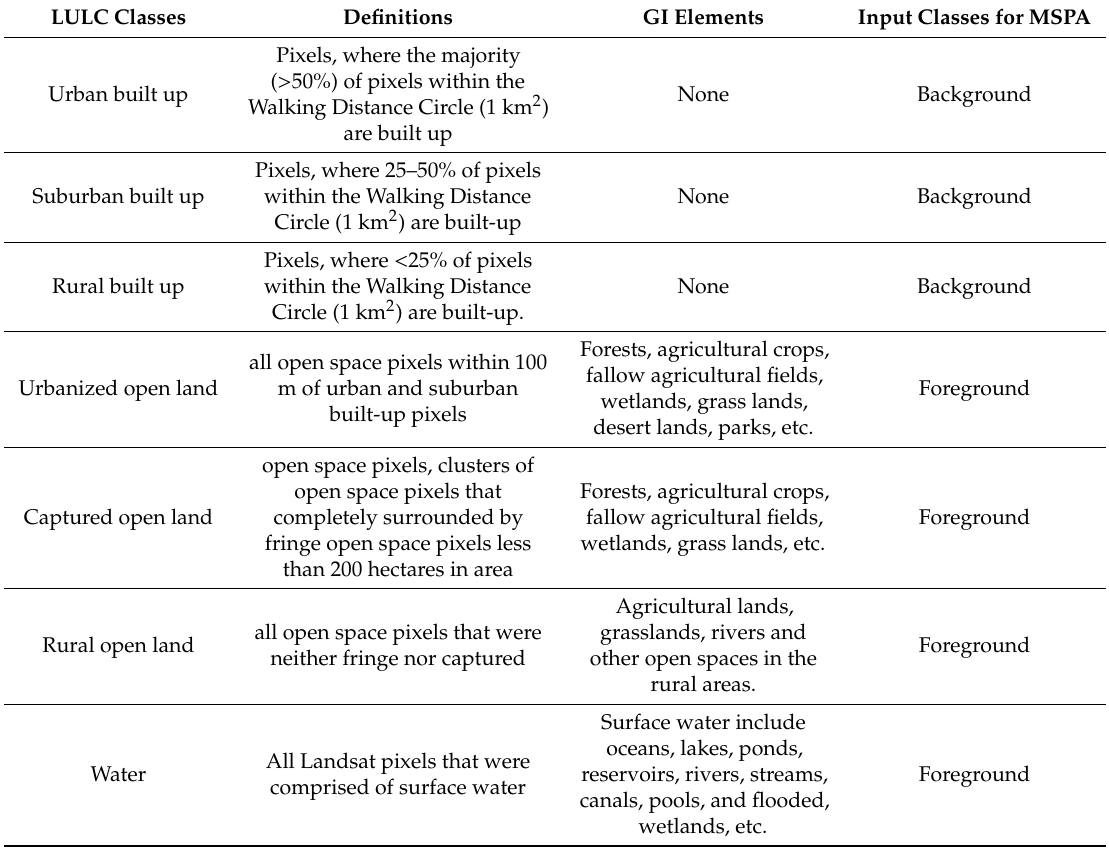
Table 1. Transformation of Land Use and Land Cover (LULC) types from the Atlas of Urban